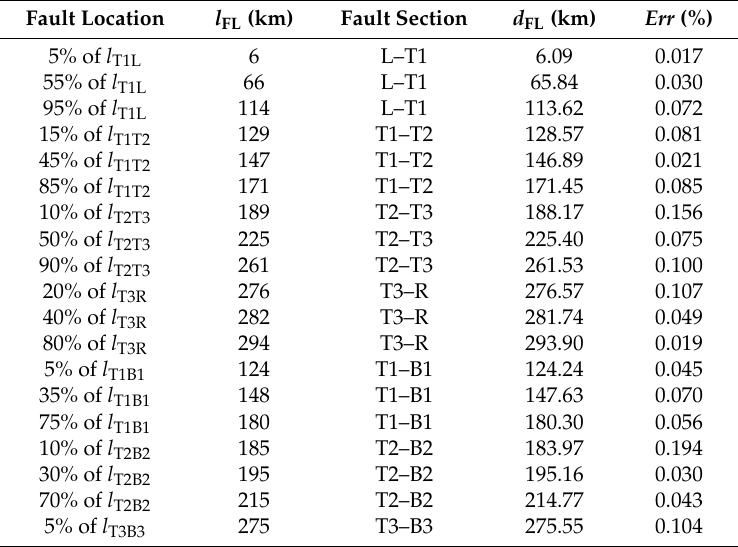
Table 5. Section identification and fault location in different positions.